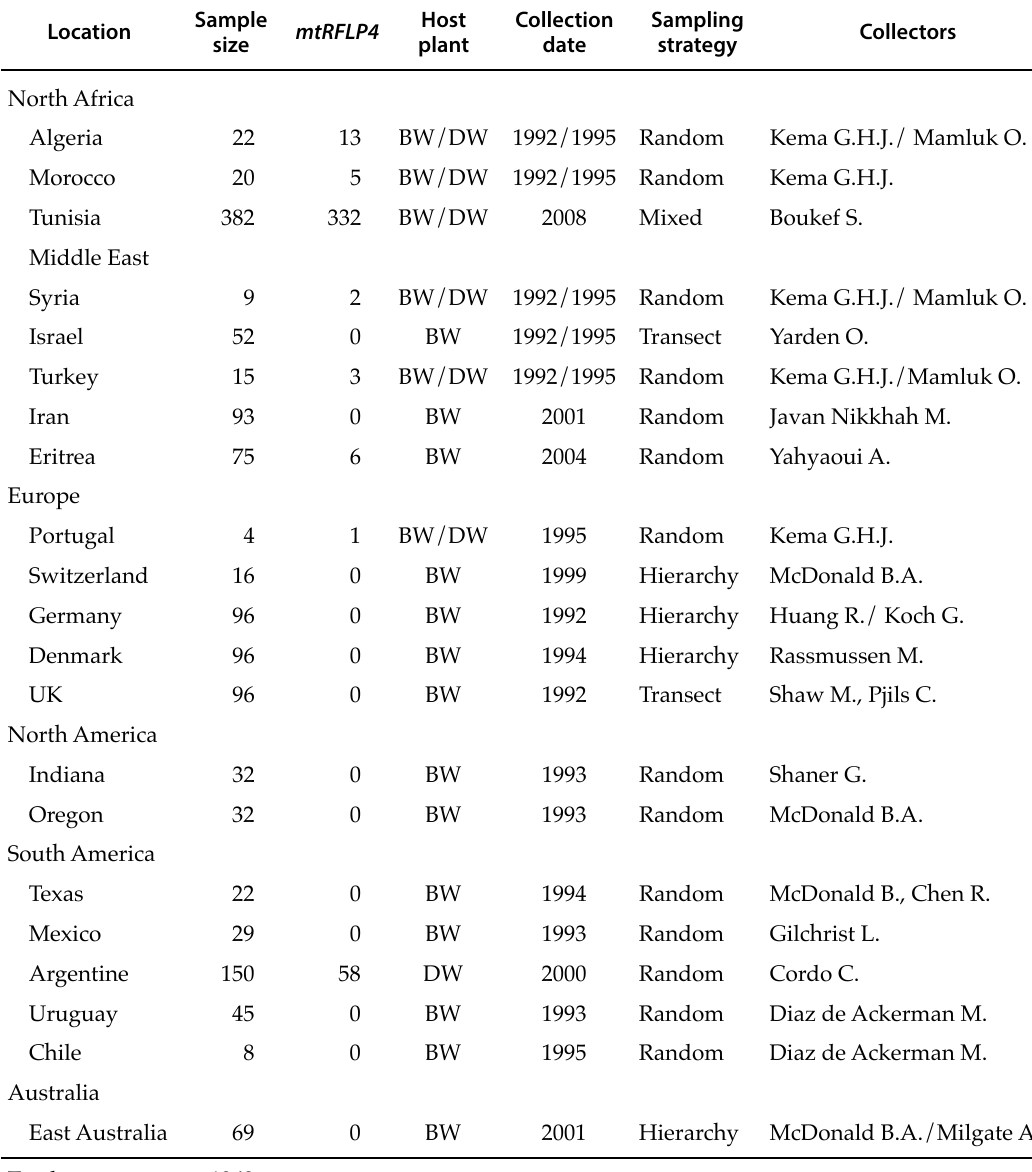
Table 1. Global Zymoseptoria tritici populations, and their mitochondrial types, included in this study.